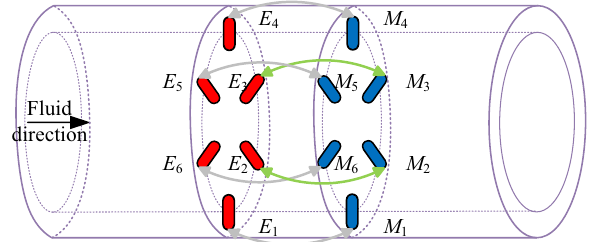
Fig. 1 Sketch of MCPA geometry